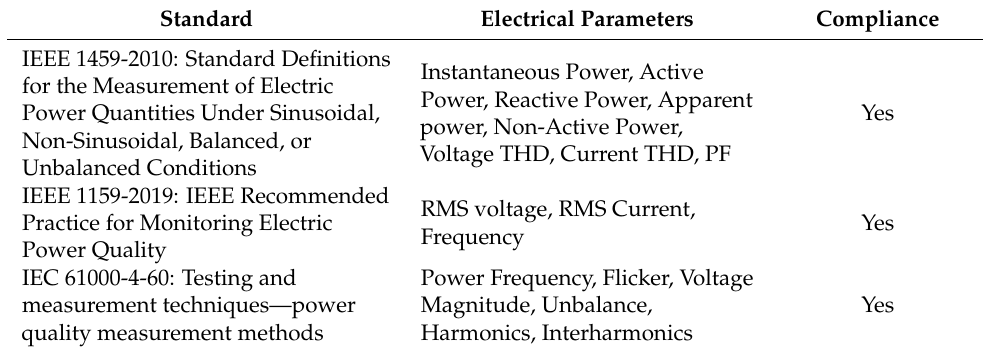
Table 1. Summary of the standards compliance of the proposed RT-based measurement